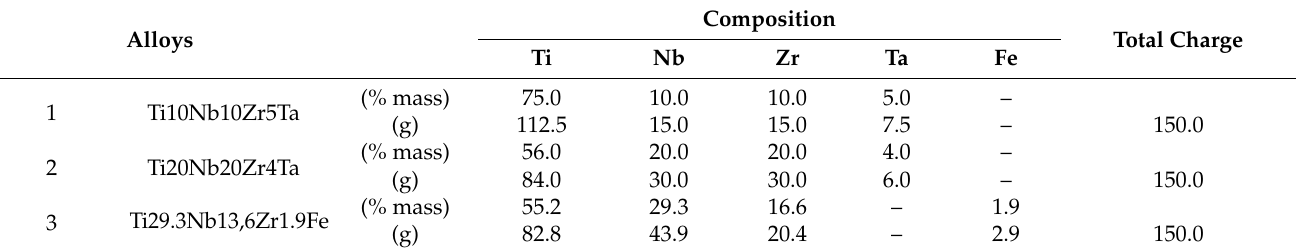
Table 1. Chemical composition of the alloys